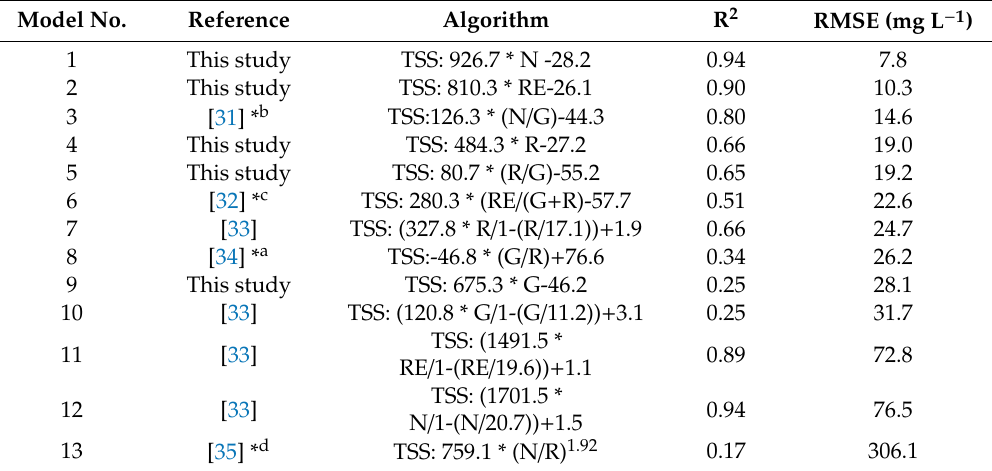
Table 3. TSS bio-optical models and statistical results.